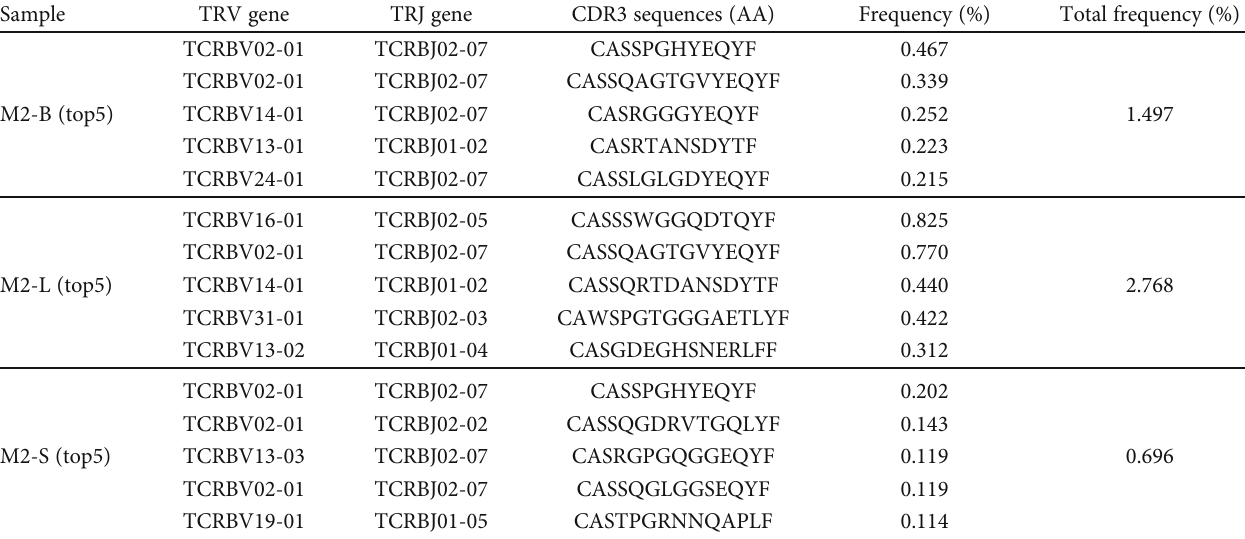
Table 2: Analysis of composition and characteristics of frequency for the top fi ve sequences and the usage of TRBV and TRBJ gene, CDR3 AA of CD4 + CD25 + T cells TCR β CDR3 repertoires in breast tumor tissues, lung metastatic tissues, and spleens from 4T1 tumor-bearing BALB/c mouse